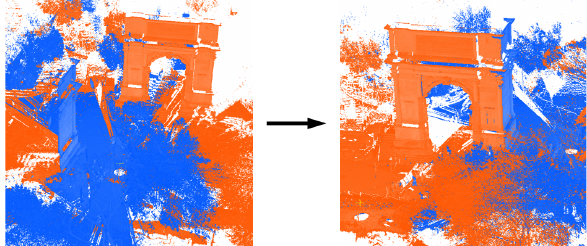
Figure 4. Registration results for point cloud pair s5-s1 of Arch